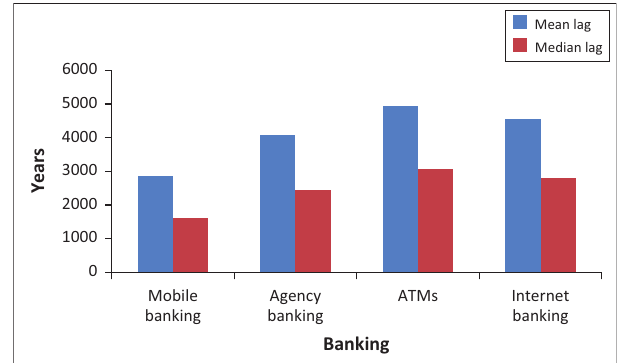
FIGURE 3: Financial innovation speed of adjustment to firm-level drivers.